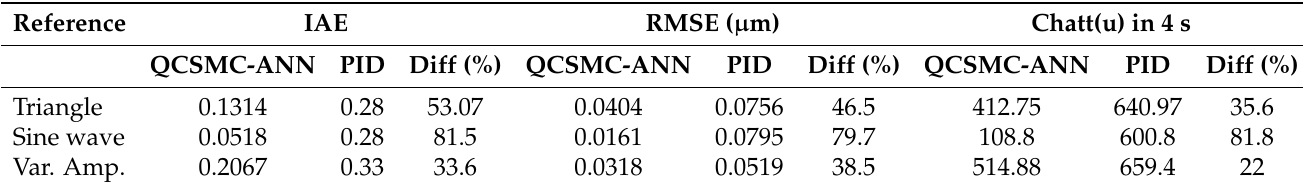
Table 2. A comparison of the different